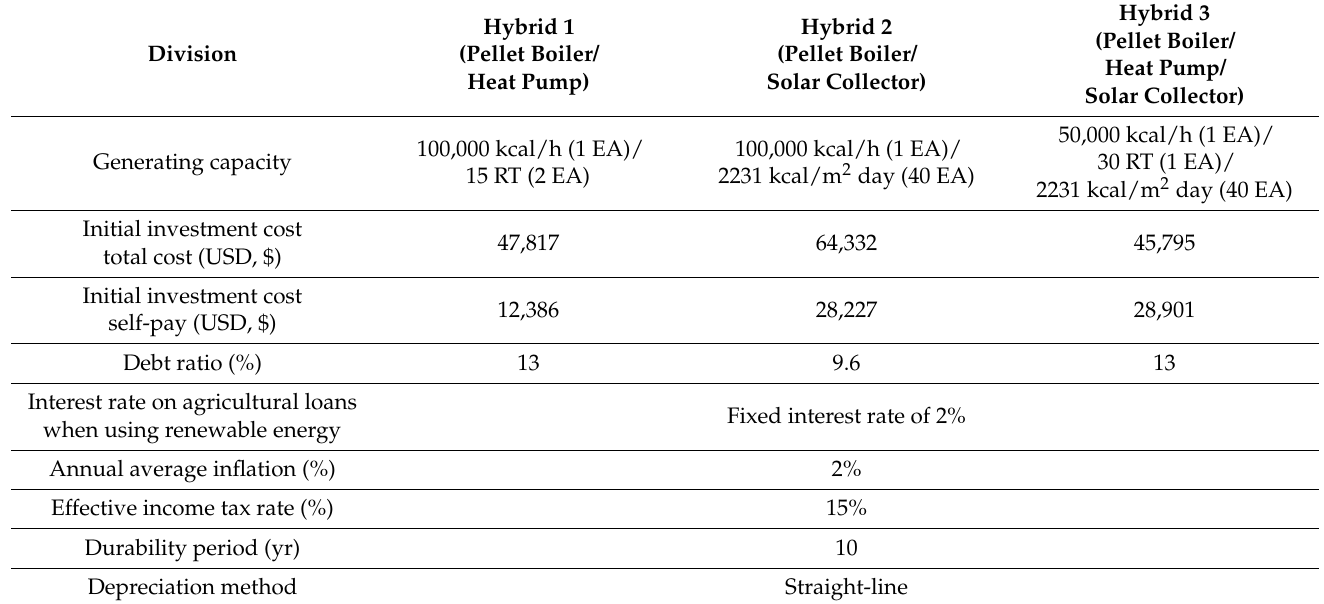
Table 2. Factors used in economic analysis.